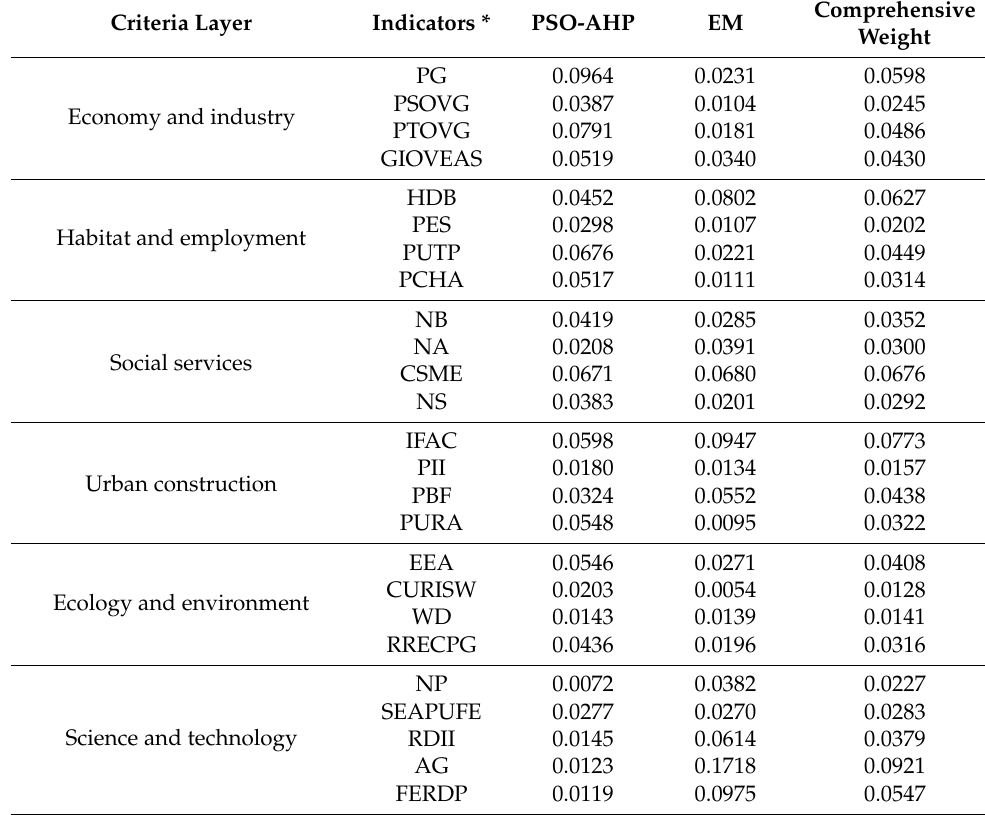
Table 4. Evaluation index weights in